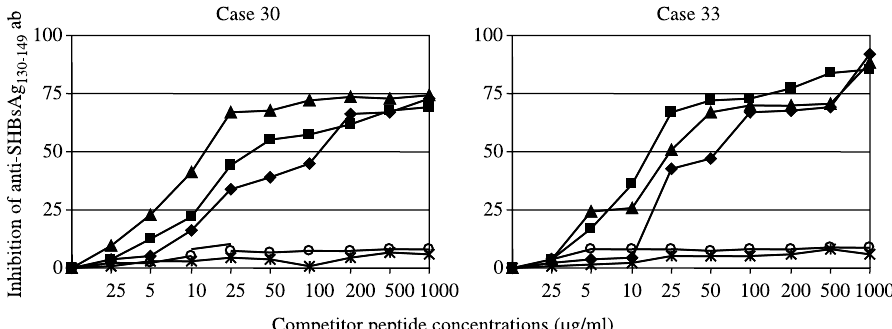
Figure 2. Inhibition of antibody binding against SHBsAg 130-149 by pre-incubation with SHBsAg 130-149 ( V ), MOG 5-24 ( B ), SHBsAg ( O ), control antigen ( W ) and control peptide (*) of case 30 and 33. On the vertical axis is the percentage of inhibition of antibody binding to the peptide in the presence of competitor peptide or antigen at different concentrations. SHBsAg 130-149 , Small Hepatitis B surface antigen; MOG, myelin oligodendrocyte glycoprotein; ab,